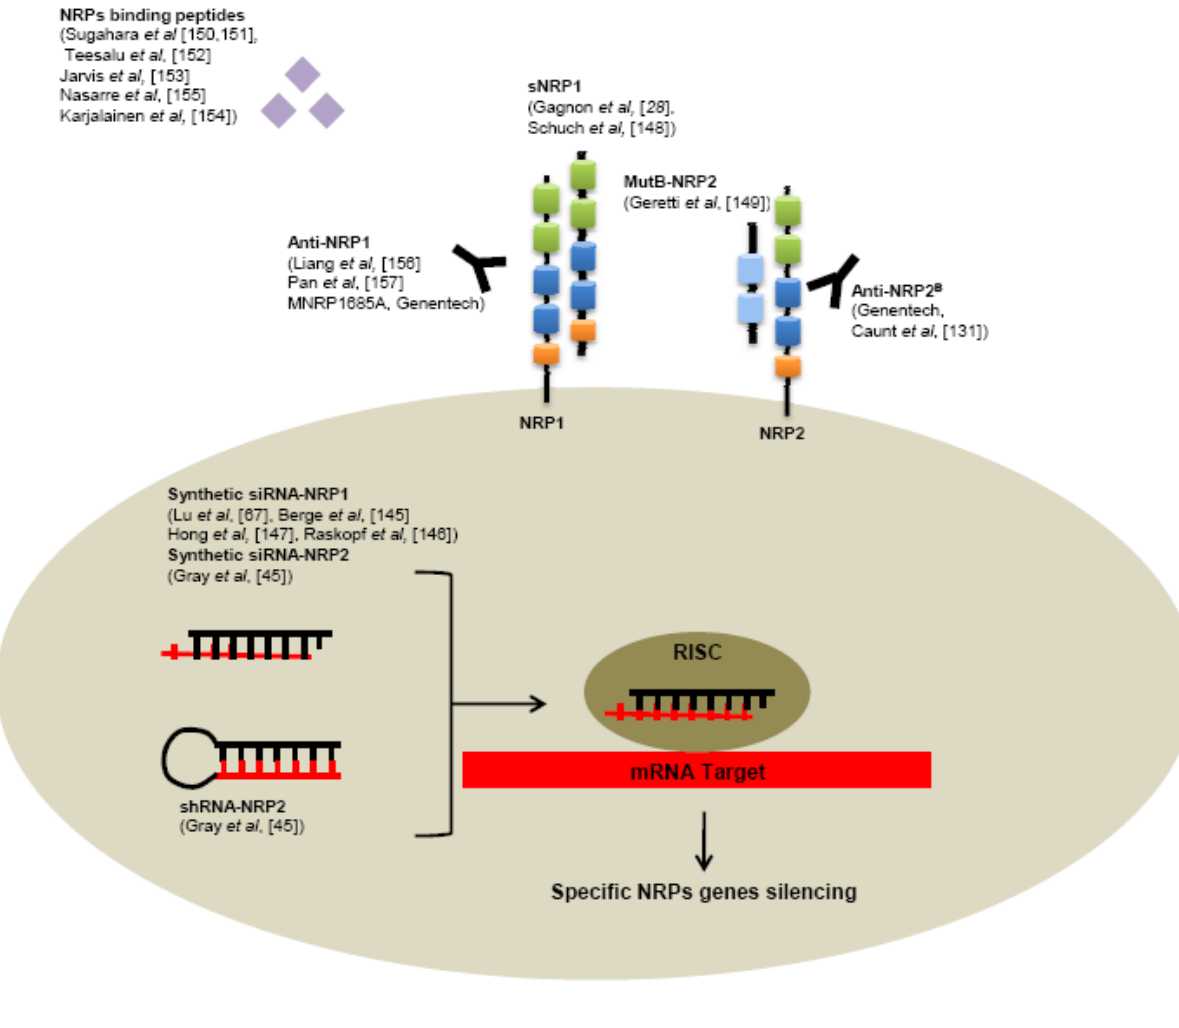
Figure 5. Biotechnological tools developped to target NRPs. Preclinical studies demonstrated the potential interest of several strategies to inhibit oncogenic functions induced by NRPs including: small interfering RNA, peptides, soluble NRPs antagonists, monoclonal antibodies (RISC: «RNA-Induced Silencing Complex»)